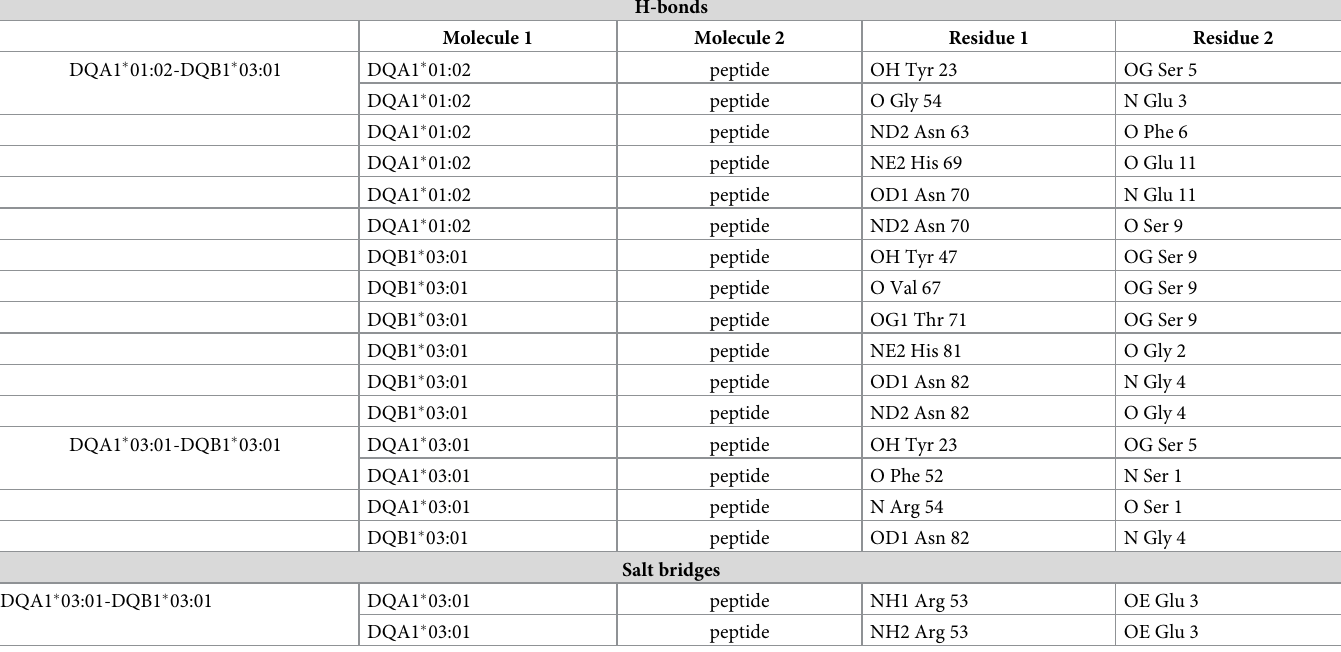
Table 3. All the hydrogen bonds and the salt bridges between DQA/DQB chains and the peptide in both structures. Columns ‘Molecule 1’/‘Residue’ 1 list the α or β chain of each DQ complex (column ‘Molecule 1’) and the residues that interact with the peptide (column Residue 1). Column ‘Molecule 2’ refers always to the peptide. In column ‘Residue 2’ the peptide’s residues that form H-bonds and salt bridges with any DQ-complex amino acid are listed. The atoms involved are shown. H-bonds Molecule 1 Molecule 2 Residue 1 Residue